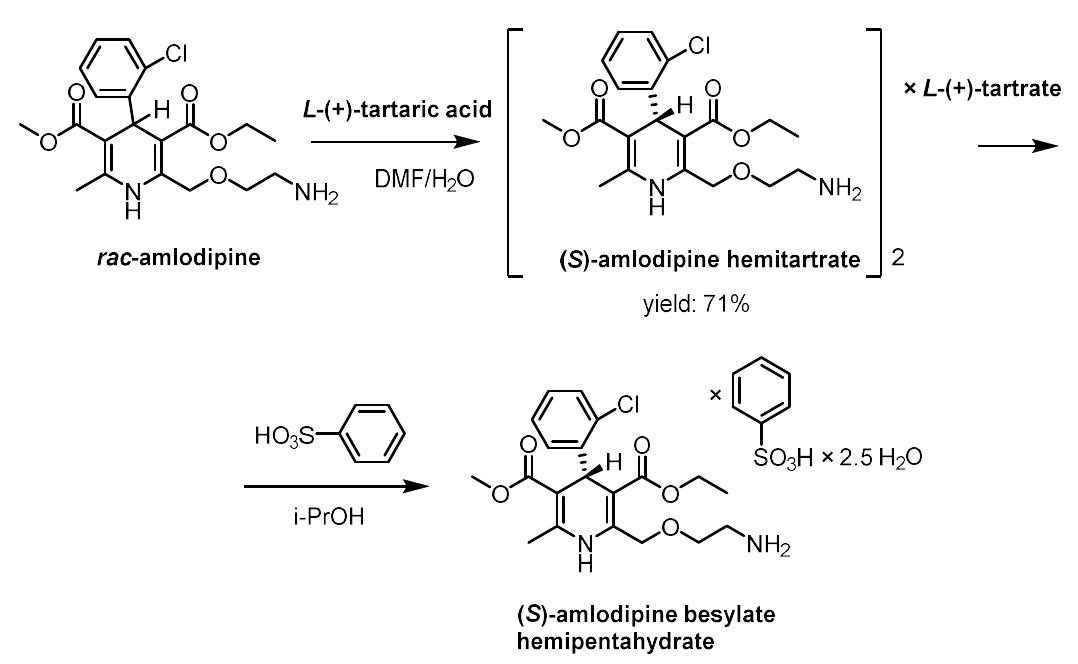
Scheme 1. Resolution of amlodipine with tartaric acid [49].